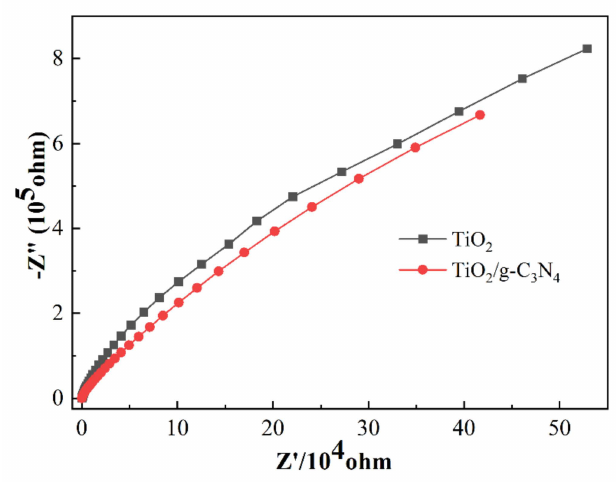
Figure 8. The EIS of pure TiO 2 and TCN-T 550 .